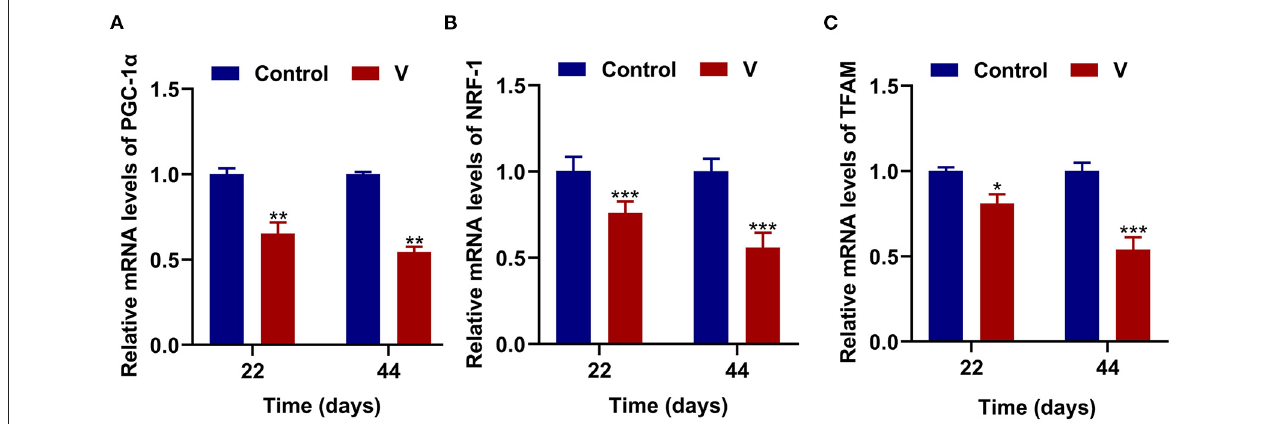
FIGURE 3 | The effects of V on mitochondrial biogenesis in the heart of ducks. (A) The mRNA levels of PGC-1 α . (B) The mRNA levels of NRF-1. (C) The mRNA levels of TFAM. * p < 0.05, ** p < 0.01, and *** p <